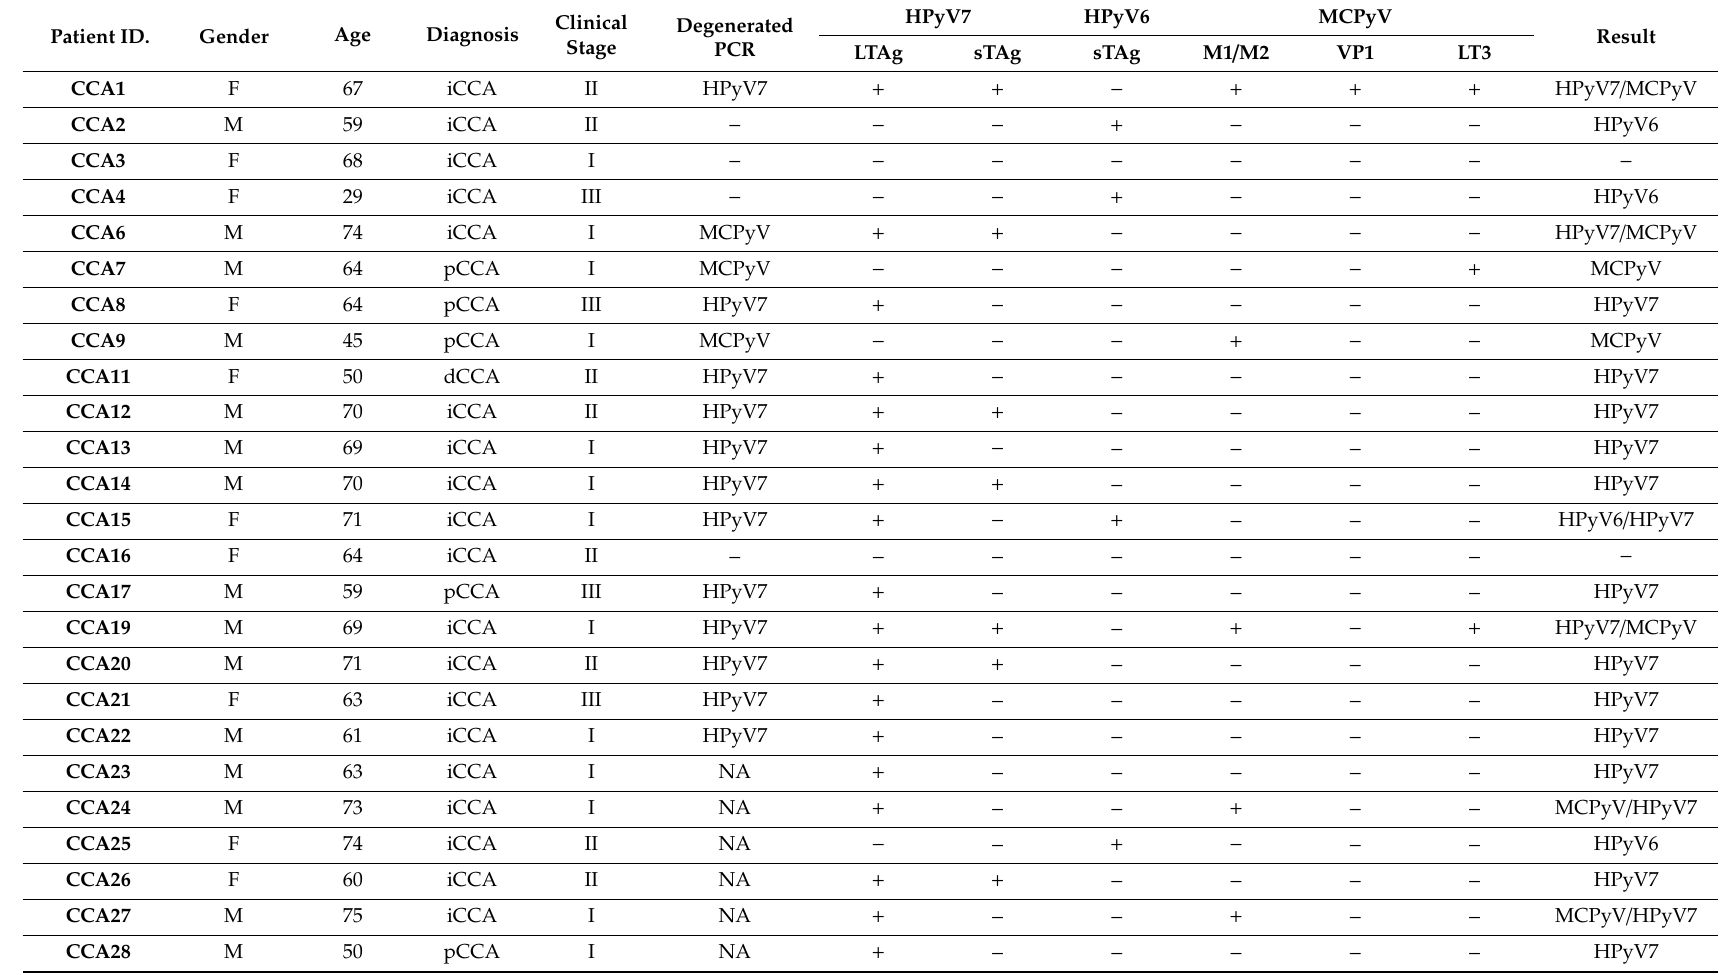
Table 1. Clinical data and DNA PCR